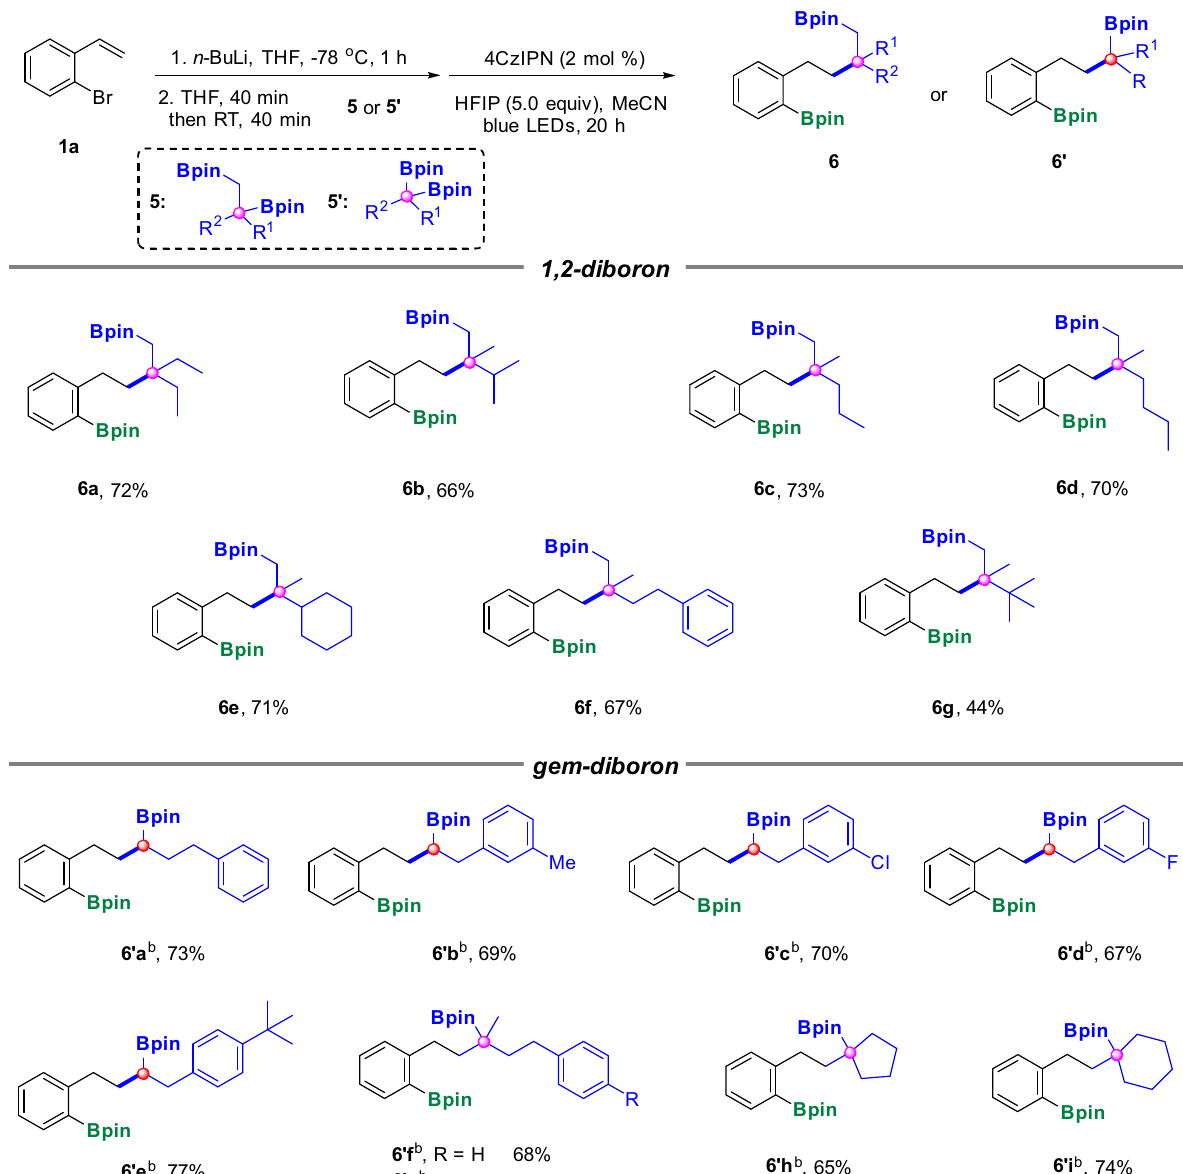
Fig. 3 Scope of 1,2-diborons and gem- diborons. [a] Reaction conditions: To a solution of o -bromostyrene 1a (0.26 mmol, 1.3 equiv) in THF (0.6 mL) was added n- BuLi (0.26 mmol, 1.3 equiv) − 78 °C under argon, the resulting mixture was stirred at − 78 °C for 1 h, then 5 (0.2 mmol, 1.0 equiv) in THF (0.2 ml) was added and stirred at − 78 °C for 40 min and warm to room temperature for 40 min, then followed by HFIP (1.0 mmol, 5.0 equiv) and 4CzIPN (2 mol%) in MeCN (2 mL, 0.1 M). The resulting mixture was irradiated by blue LEDs for 20 h; [b] With removing the THF at the third Fig. 2, different types of tertiary alkyl mono-boronic esters were good substrates, and both the boron moiety and the tertiary ali- phatic groups were smoothly incorporated into the eventual products ( 4a – 4n ), remarkably, along with the formation of an all- carbon quaternary carbon center.